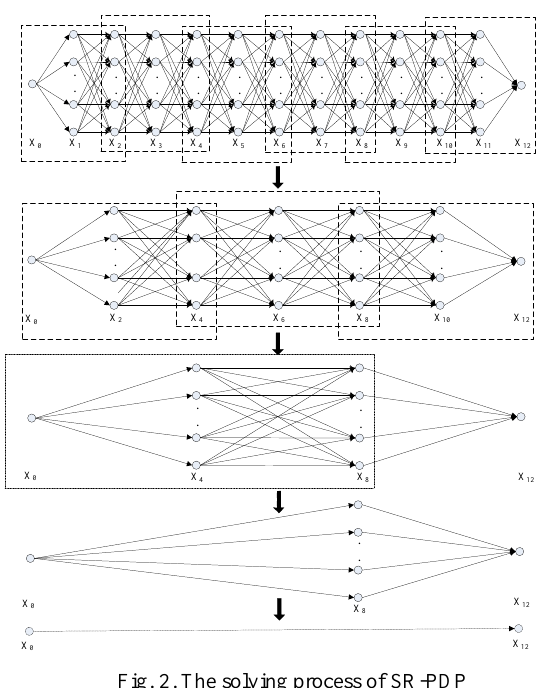
Fig. 2. The solving process of